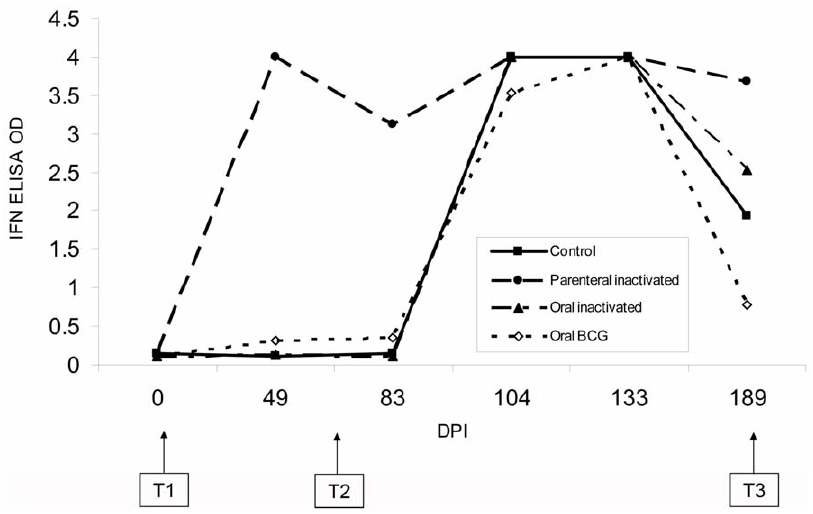
Figure 4. Detection of gamma interferon. Mean optical density (OD) readings of the gamma interferon ELISA (n=5 for each point and group).